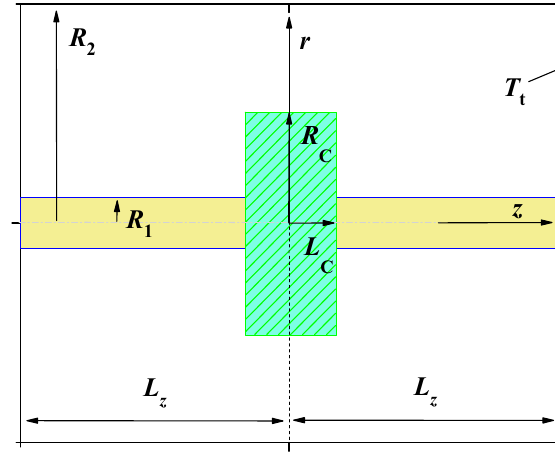
Figure1. Disc-shaped heating zone around CNT (not to scale). Figure 1. Disc-shaped heating zone around CNT (not to scale).